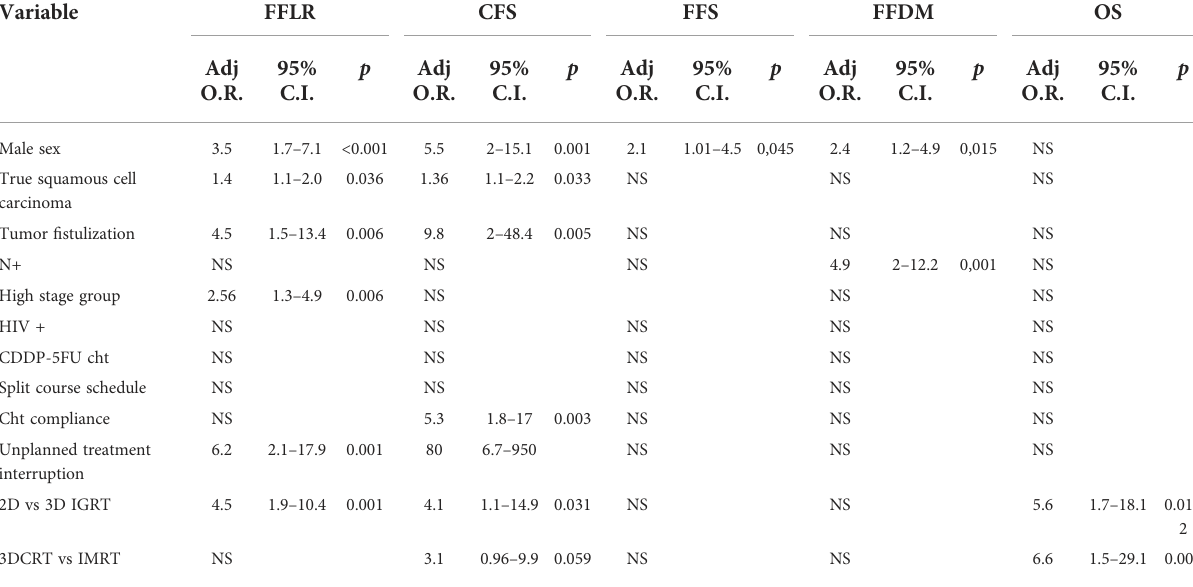
TABLE 2 Multivariate analysis results concerning FFLR, CFS, FFS, FFDM, and OS. Variable FFLR CFS